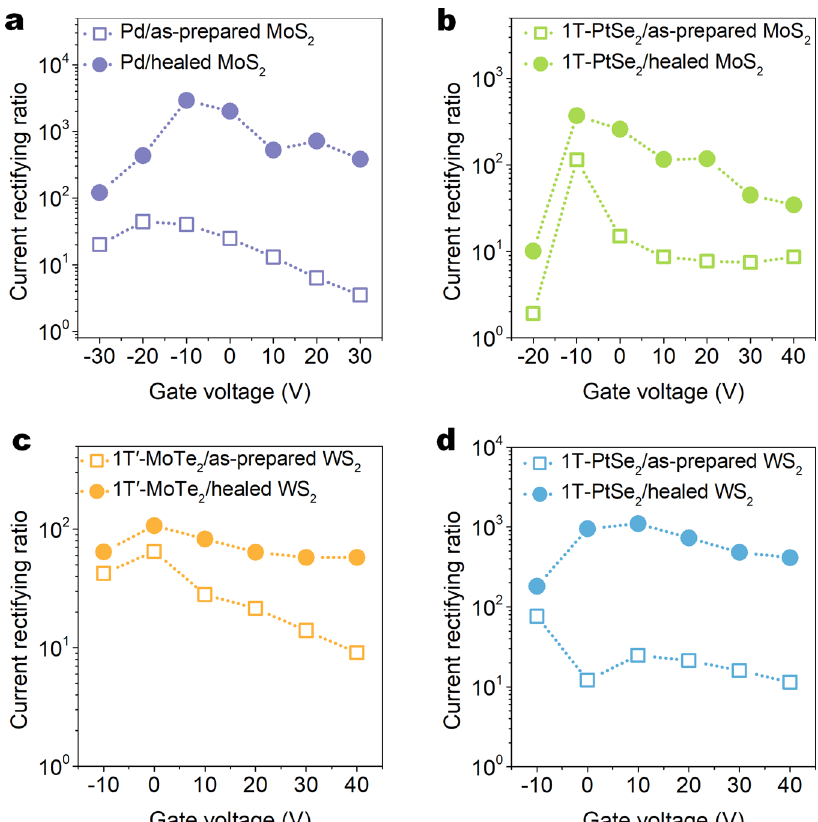
Fig. 4 Generalization of performance optimization strategy of thickening Schottky barrier width. a – d Gate-dependent rectifying ratios of the Pd/MoS 2 ( a ), 1T-PtSe 2 /MoS 2 ( b ), 1T ′ -MoTe 2 /WS 2 ( c ), and 1T-PtSe 2 /WS 2 ( d ) metal-semiconductor diodes extracted from Supplementary Fig. 11 before and after the SVSH. It should be noted that both 1T ′ -MoTe 2 and 1T-PtSe 2 are multilayer over 10 nm and behave metallic characteristics to the only function as